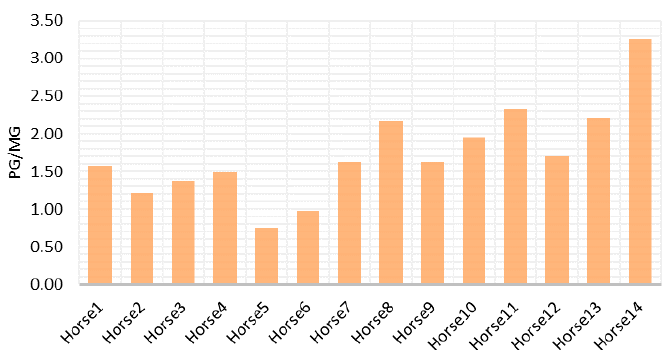
Figure 4. Cortisol level in horsehair (pg/mg) of each subject considered in the research.